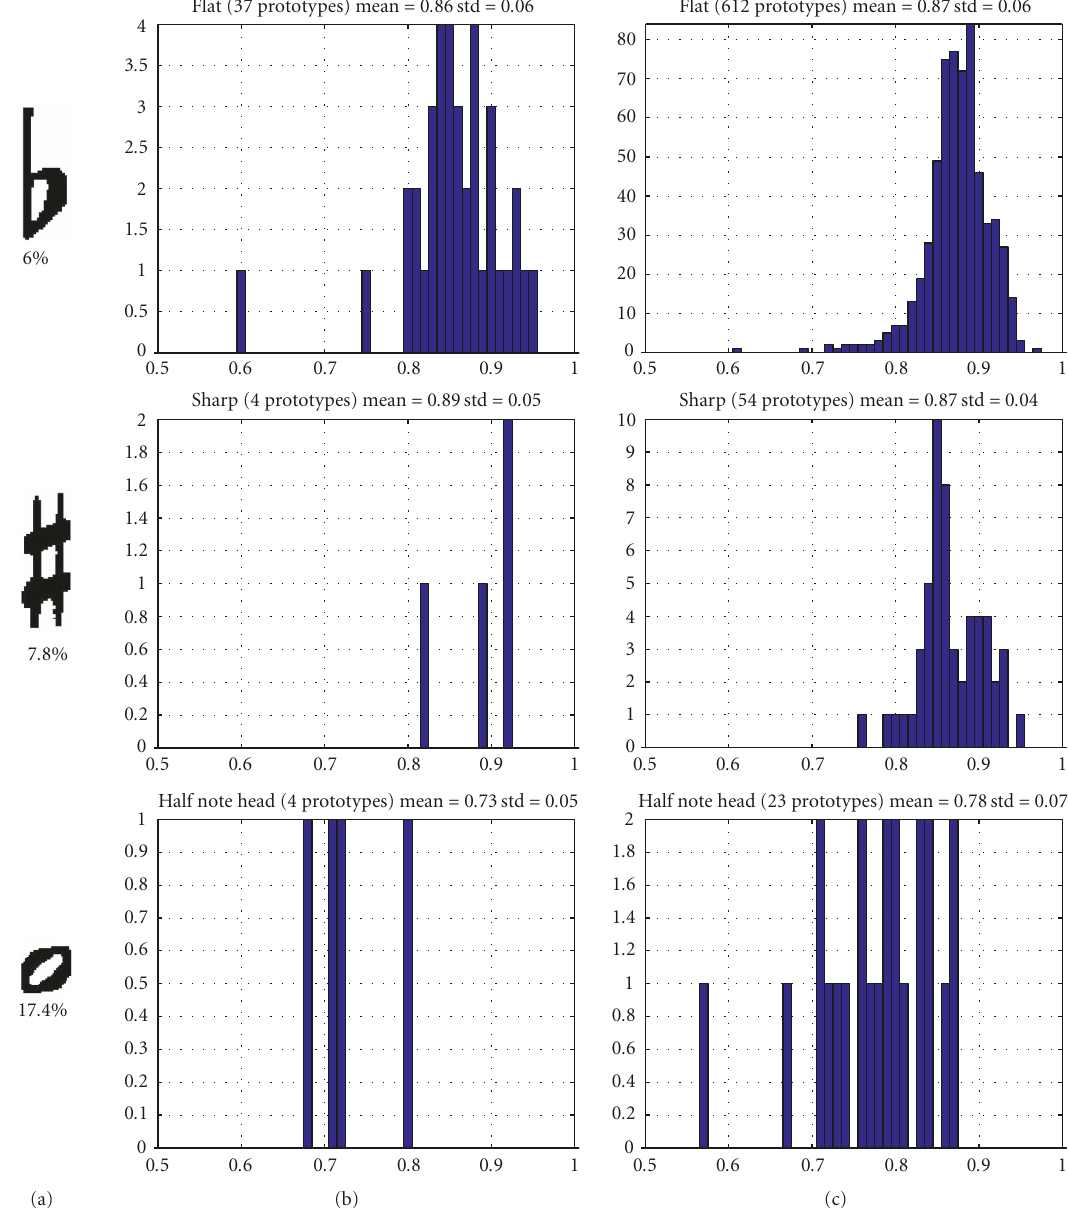
Figure 17: Examples of symbol model learning . (a) The learnt model M k for class k and the proportion of symbols used as prototypes in the a and the prototypes of the learning database. (c) The histogram learning procedure. (b) The histogram of the correlation scores between M k a and the symbols in the whole of the correlation scores between M k a